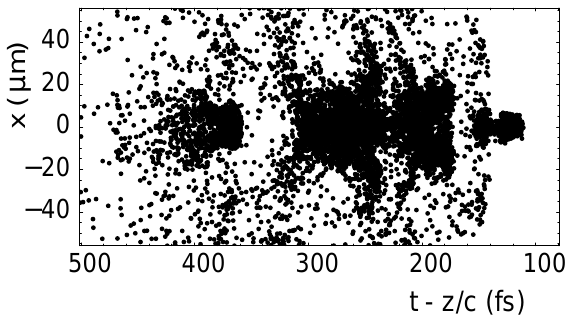
FIG. 8. Real space snapshot at 0.2 mm for a 2 nC